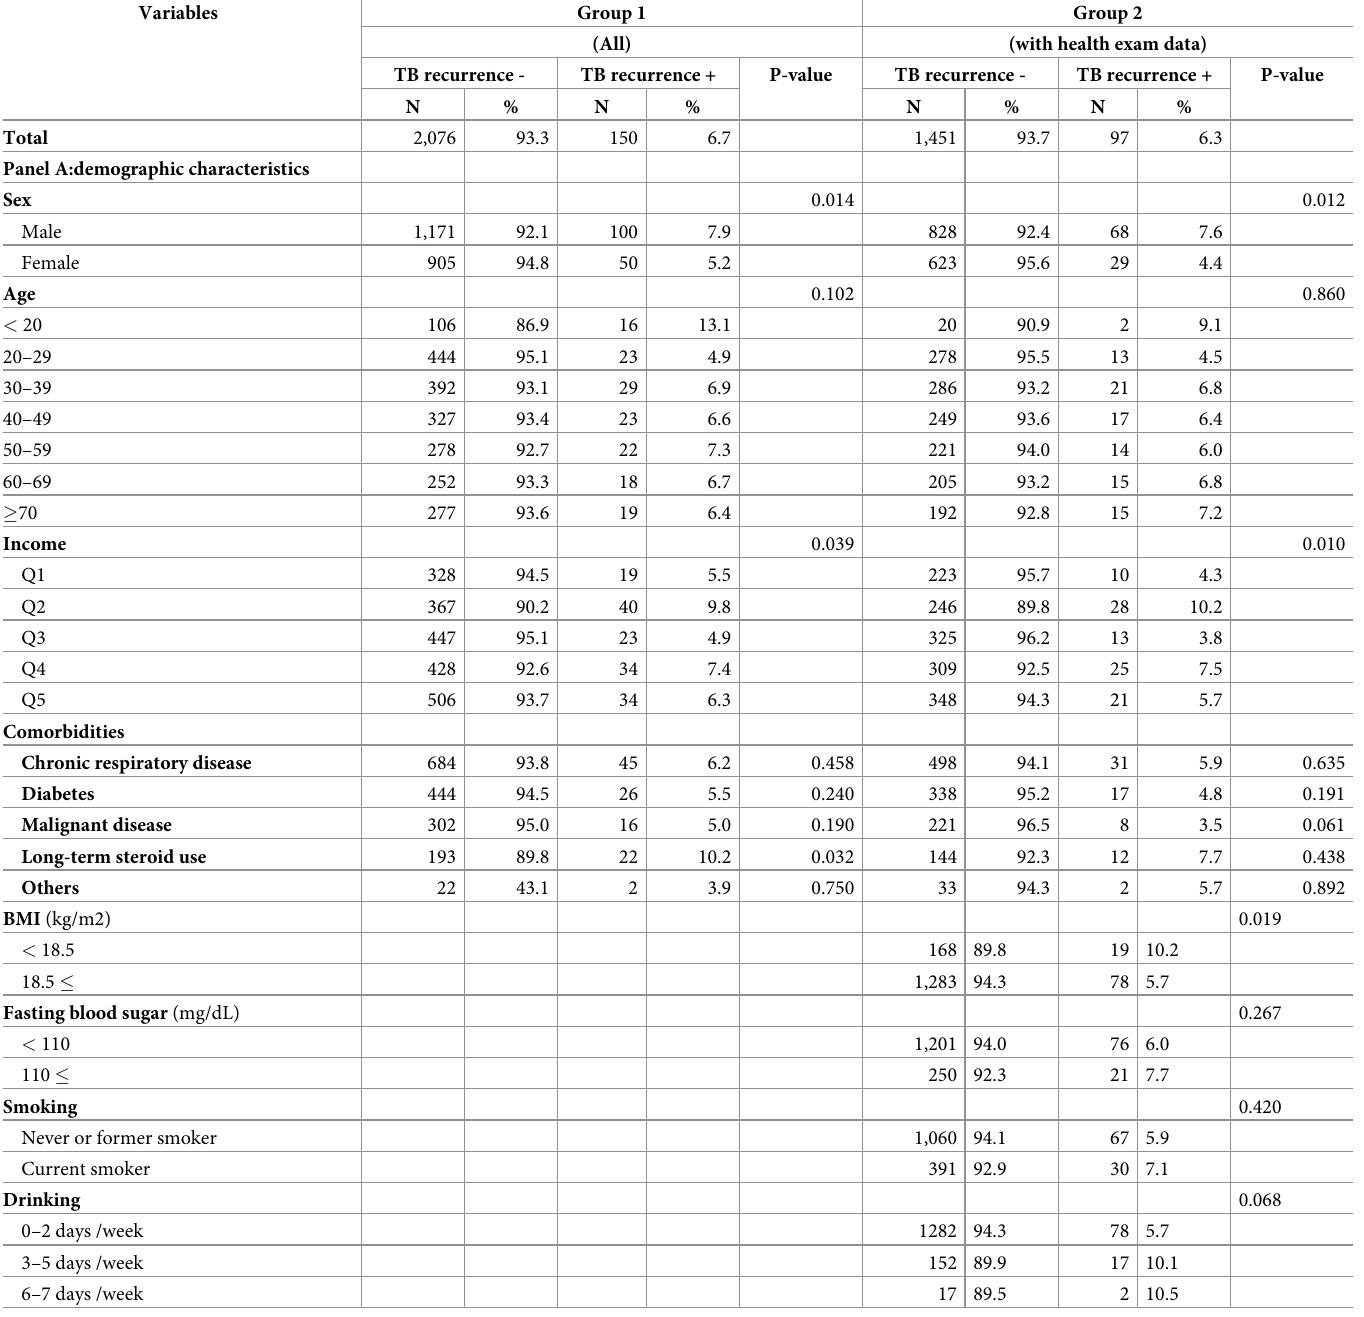
Table 2. Characteristics of study population by TB